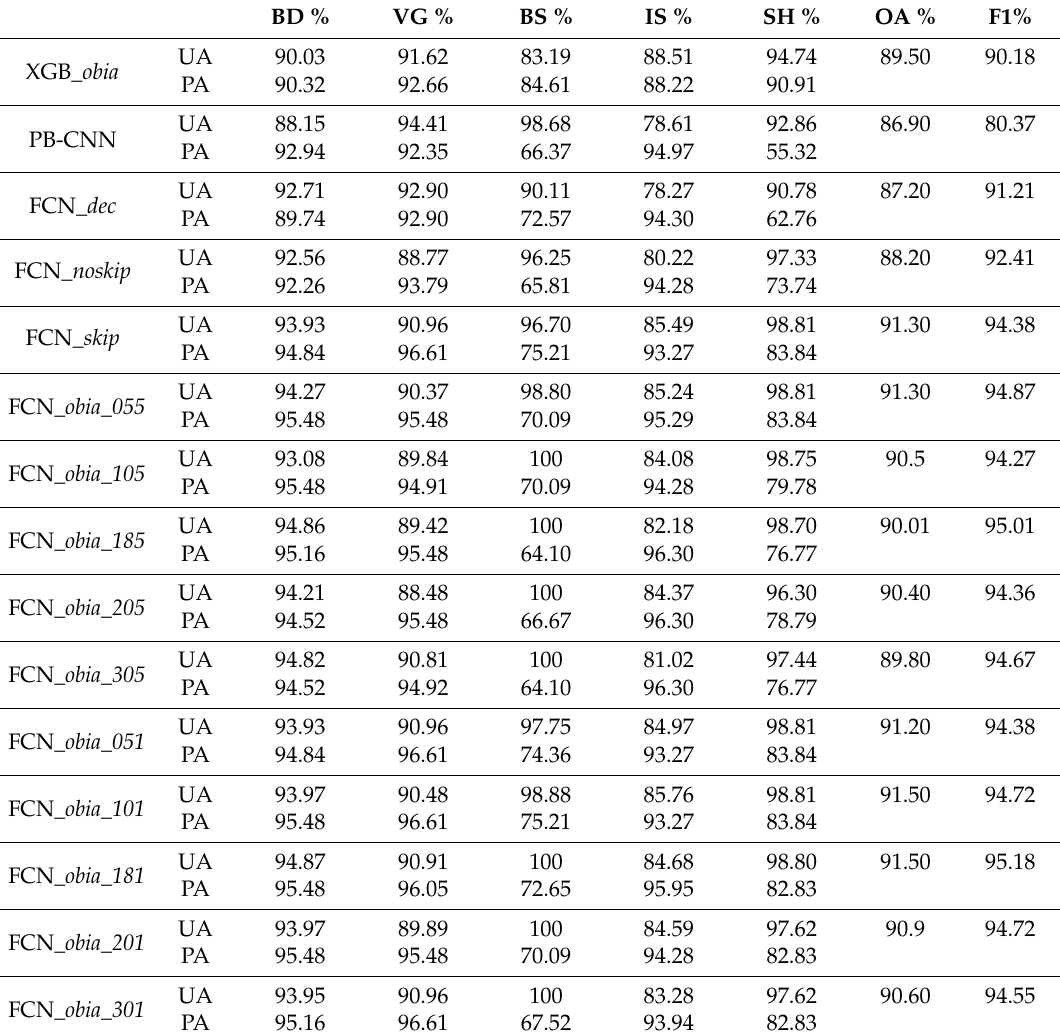
Table 2. Producer accuracy, user accuracy, overall accuracy and F1 score for the used classification methods (BD: building, VG: vegetation, BS: bare soil, IS: impervious surface and SH: